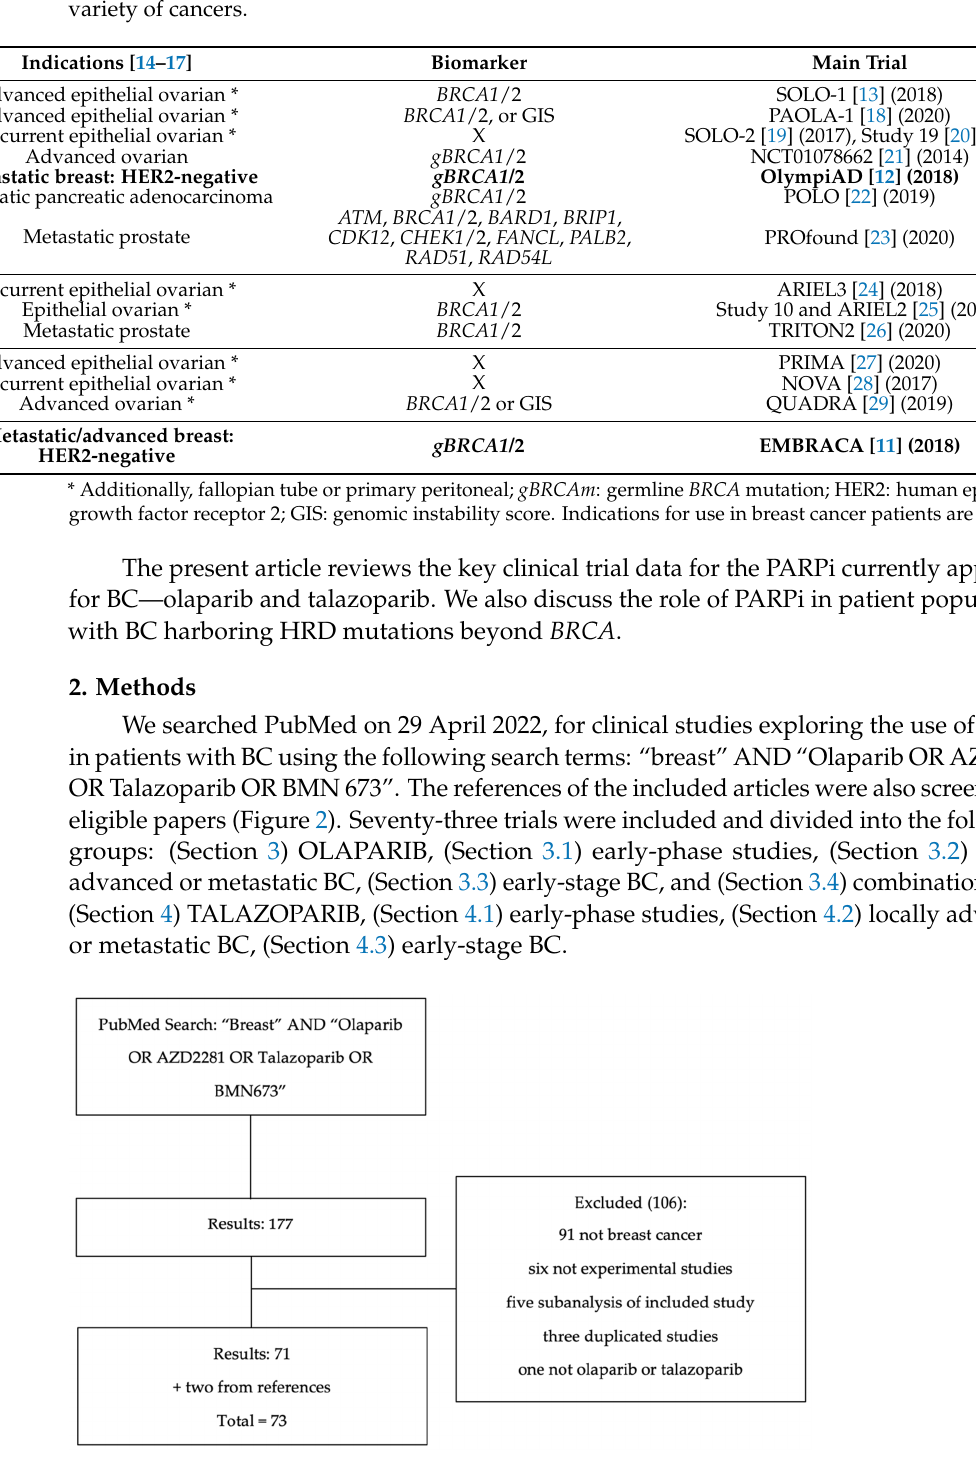
Table 2. FDA indications for poly-adenosine diphosphate ribose polymerase inhibitors (PARPi) in a variety of cancers.